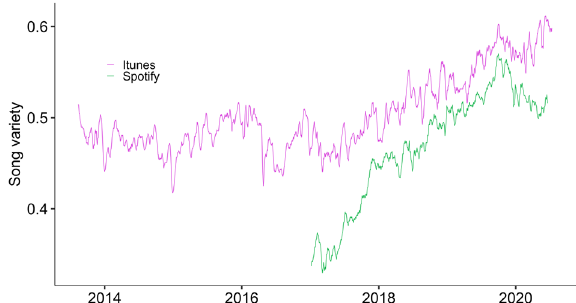
Fig. 3 Song variety on Spotify and iTunes. Values range from 0 (same set of songs in every country) to 1 (no overlap between the charts). Calculated for countries in both datasets (16 countries) and the same chart size (100 positions). Time series are calculated with daily frequency and smoothed over a 10-day window. Both Spotify and iTunes display consistent trends of increasing variety